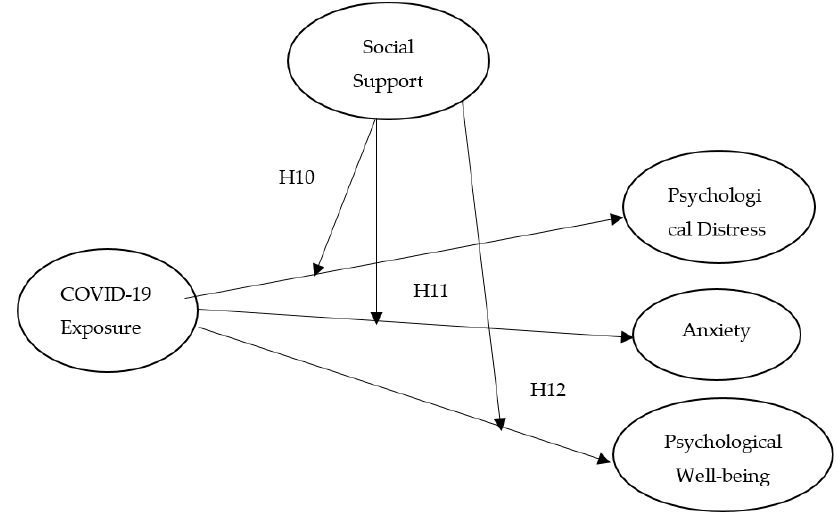
Figure 3. Moderation Model of the study (COVID-19 Exposure and mental health).